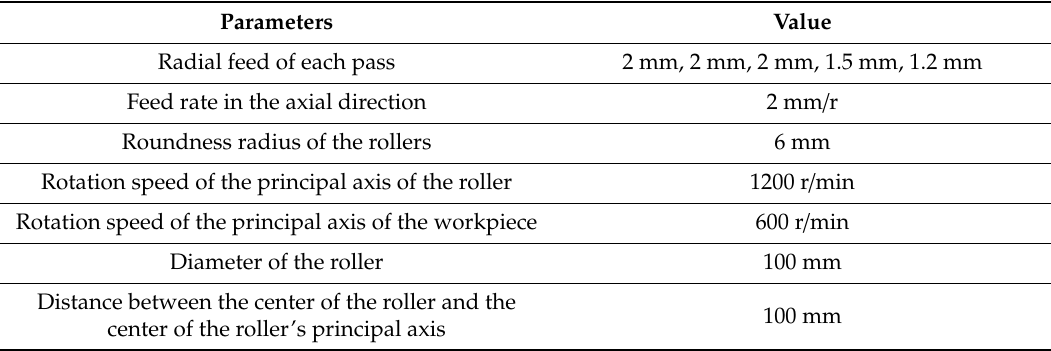
Table 2. Process parameters selected for the simulations.